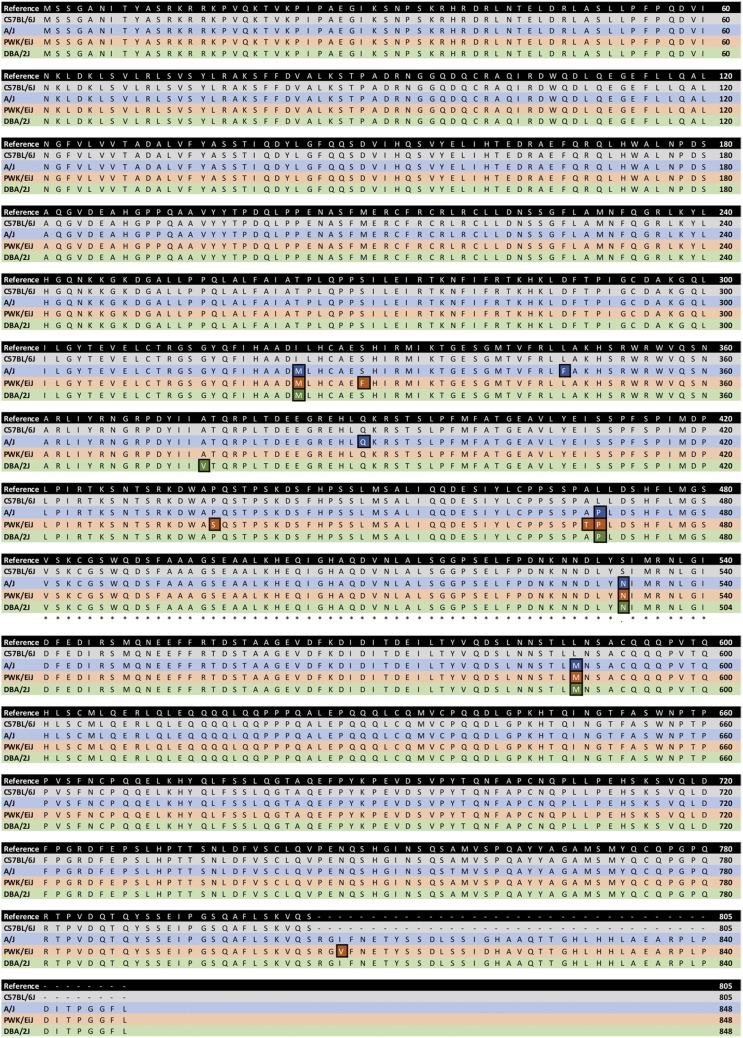
Multiple sequence alignment comparing the AHR amino acid sequence. Sequences inferred from the reference mouse genome (GRCm38) were compared with imputation results from 4 strains which carry differing alleles of the Ahr: C57Bl/6J (Ahrb1; gray), A/J (Ahrb2; blue), PWK/PhJ (Ahrb3; orange), and DBA/2J (Ahrd; green). Highlighted boxes indicate sequence variation. Black indicates the reference mouse sequence.